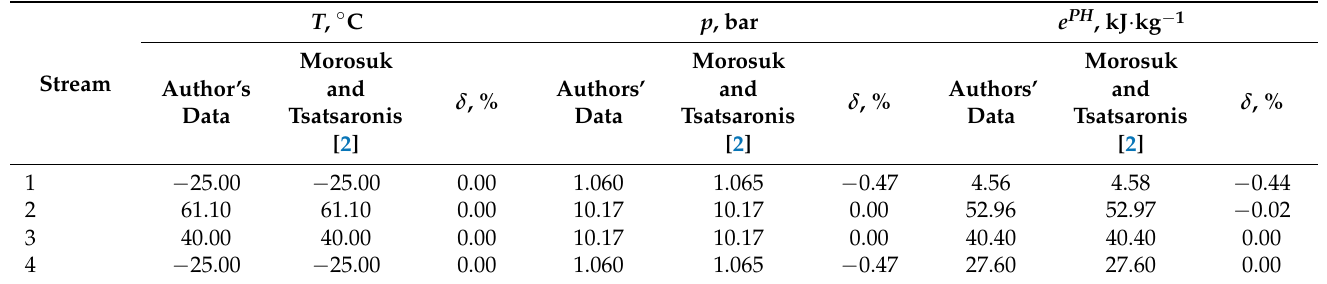
Table 2. Thermodynamic values of the real cycle with